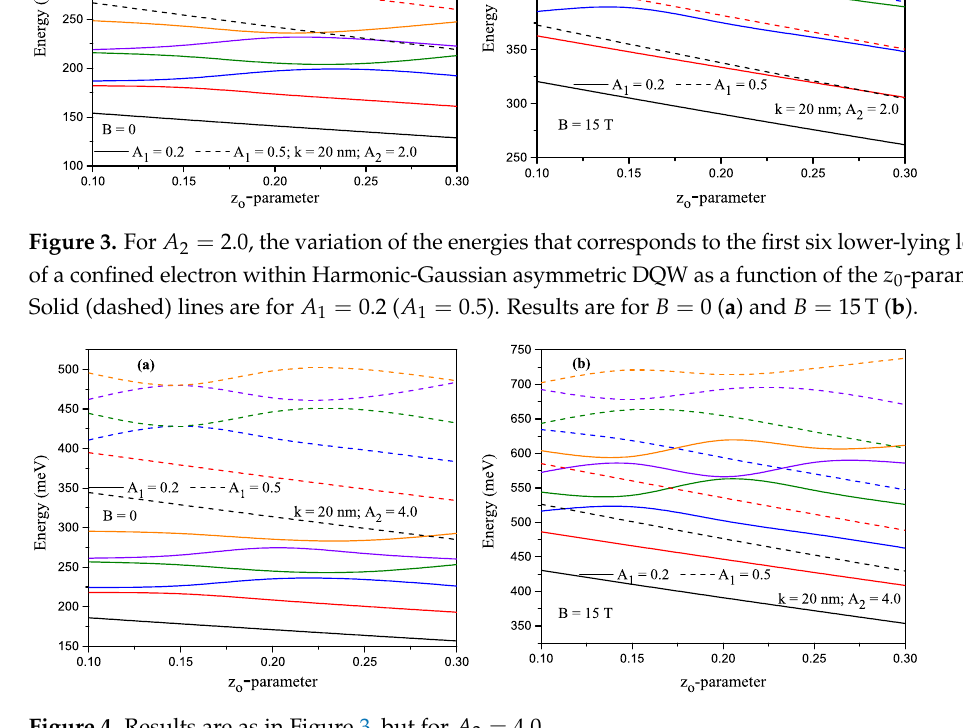
Figure 4. Results are as in Figure 3, but for A 2 =